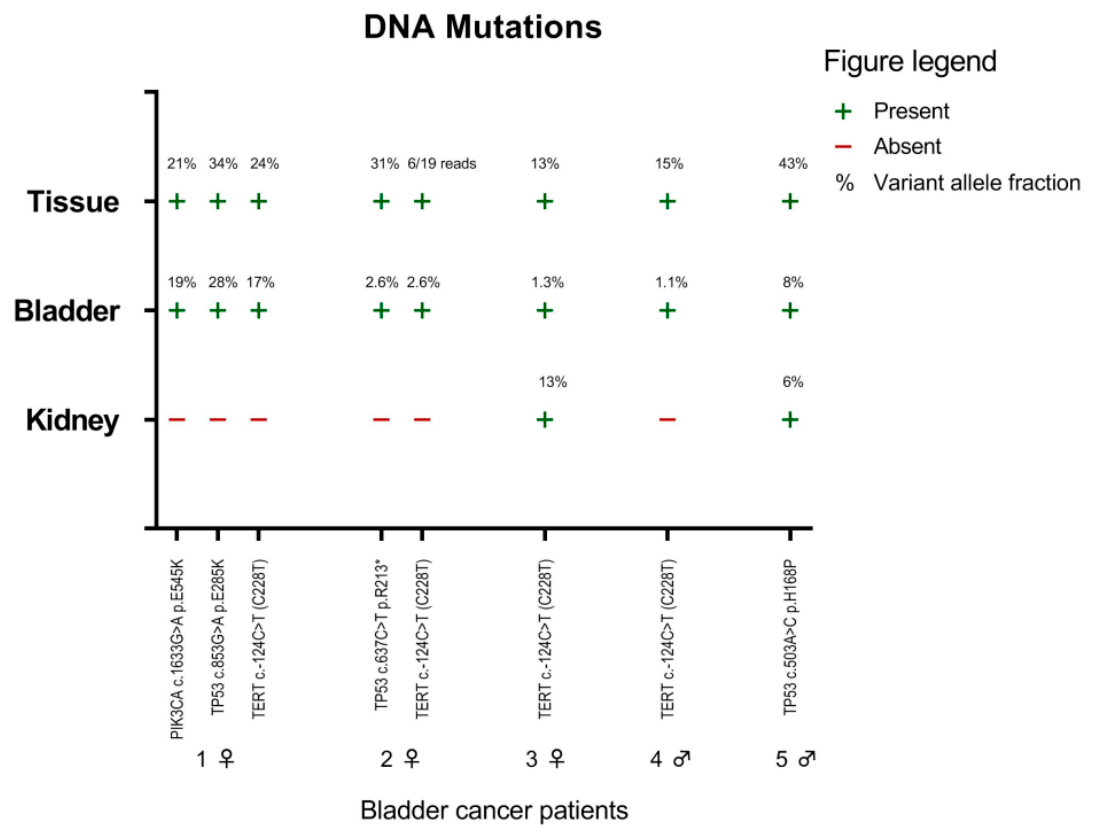
Figure 3. Presence of DNA mutations in paired bladder tumor tissues (tissue), natural voided urine (bladder), and nephrostomy urine (kidney) from five muscle-invasive bladder cancer patients. The percentage (%) indicates the variant allele fraction.